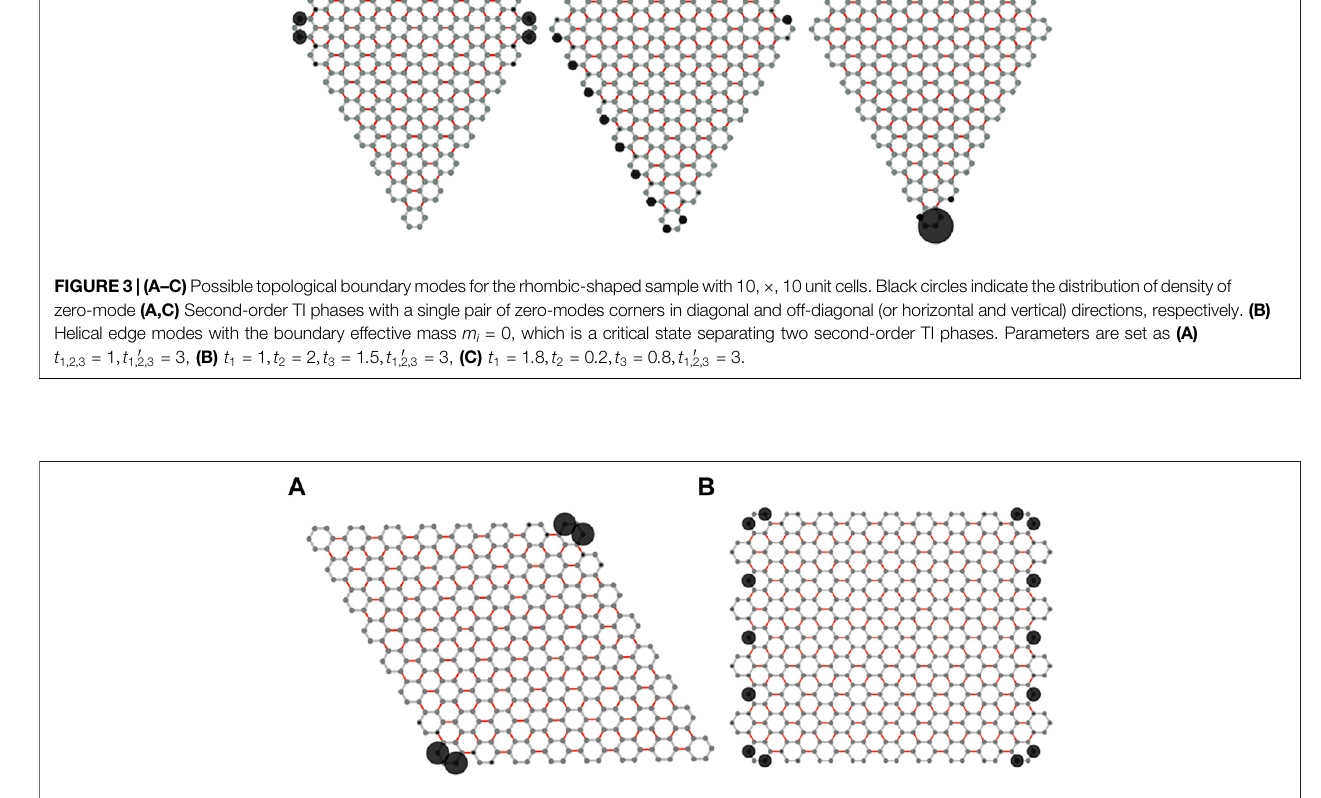
FIGURE 4 | (A) Topological corner modes in rhombic sample with t i (cid:2) 1 , t i ′ (cid:2) 3. (B) Topological edge modes in rectangle sample with same parameters as rhombic ( t 1 , 2 , 3 (cid:2) 1 , t 1 , 2 , 3 ′ (cid:2) 3 )